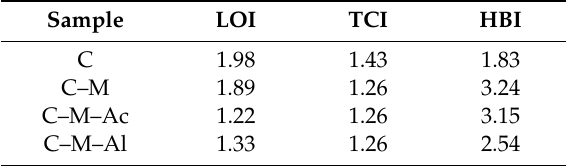
Table 3. Comparison of the lateral order index (LOI), total crystalline index (TCI) and hydrogen bond intensity (HBI) of cellulose silanized with MTMOS.